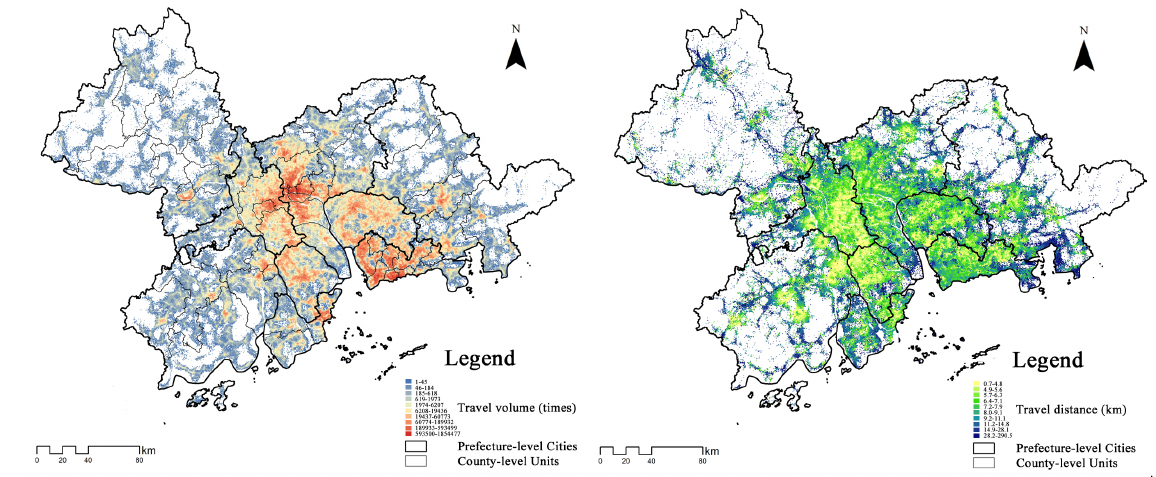
Figure 3 . The travel volume and average travel distance (km) in the PRD